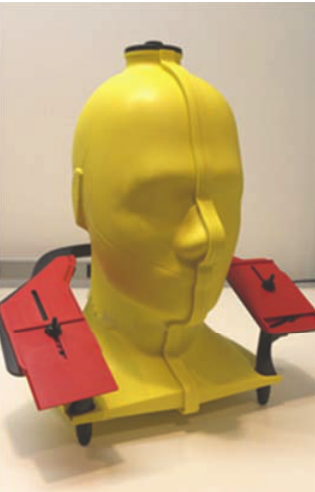
F 2: A model of the speci�c anthropomorphic mannequin (SAM)